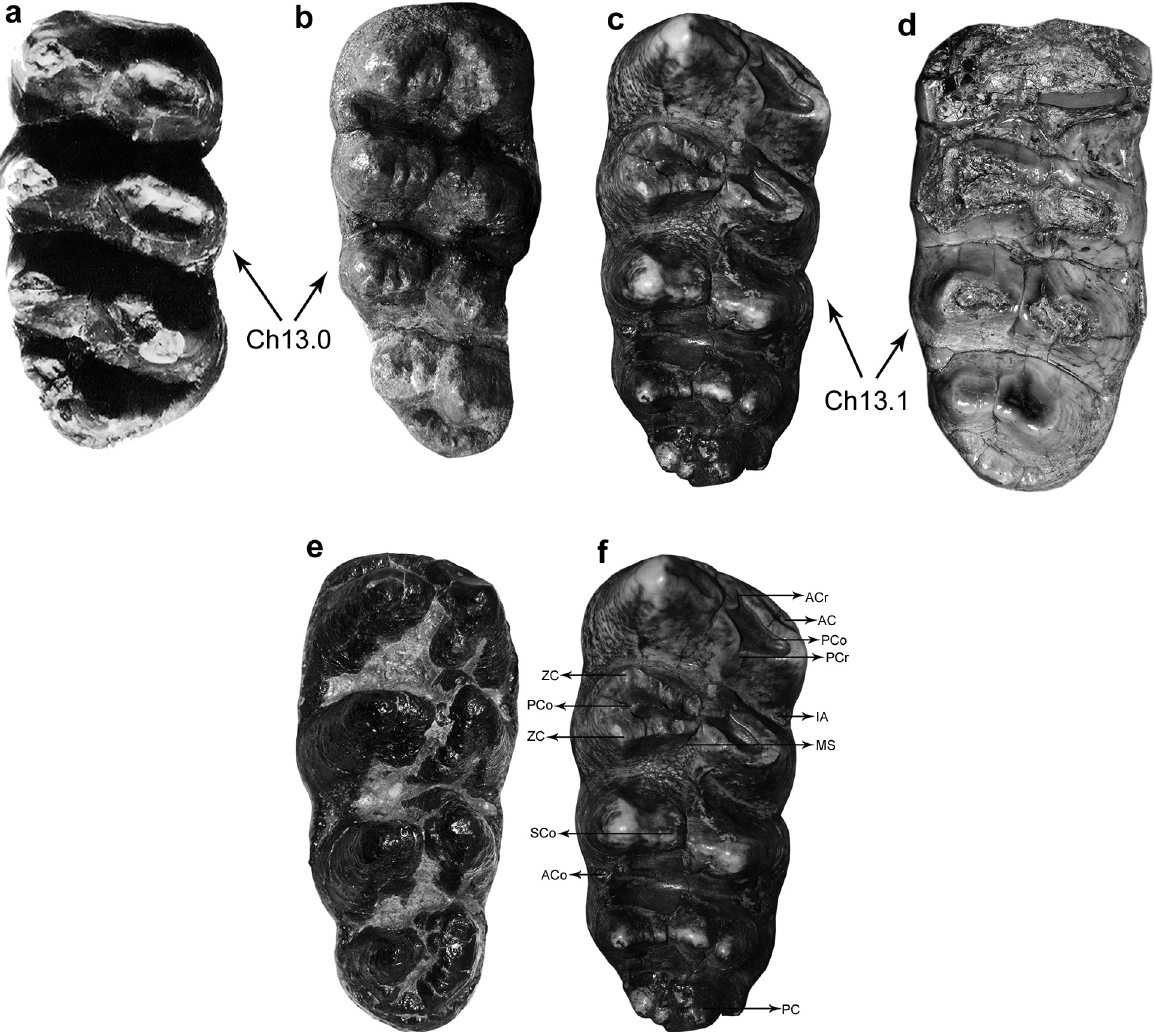
Figure 3 - Occlusal view of third lower molars (m3) of Mammutidae ( a , b , c ) and Gomphotheriidae ( e ) compared to m3 of Sinomammut tobieni gen. et sp. nov. ( d ). Note the difference between the molar morphology, the shape of wear fi gures and the molar structures studied in this paper (abbreviations are explained on text). ( a ) Eozygodon morotoensis right m3 (from Tassy and Pickford, 1983); ( b ) Zygolophodon right m3 (AMNH 26461); ( c ) and ( f ) Mammut americanum left m3 (AMNH 14294); ( d ) Sinomammut tobieni right m3 (GIOTC 0984-9-178); ( e ) Gomphotherium left m3 (AMNH 1908). Specimens ( c ), ( e ) and ( f ) are horizontally turned in order to facilitate anatomy recognition and comparisons. The only synapomorphy shared by S. tobieni and M. americanum - Presence of a pronounced crest-like habitus on molars - is indicated by the arrows and the abbreviation Ch13.1 (derived state, ( c ) and ( d )) and Ch13.0 (primitive state, ( a ) and ( b )). All specimens are out of